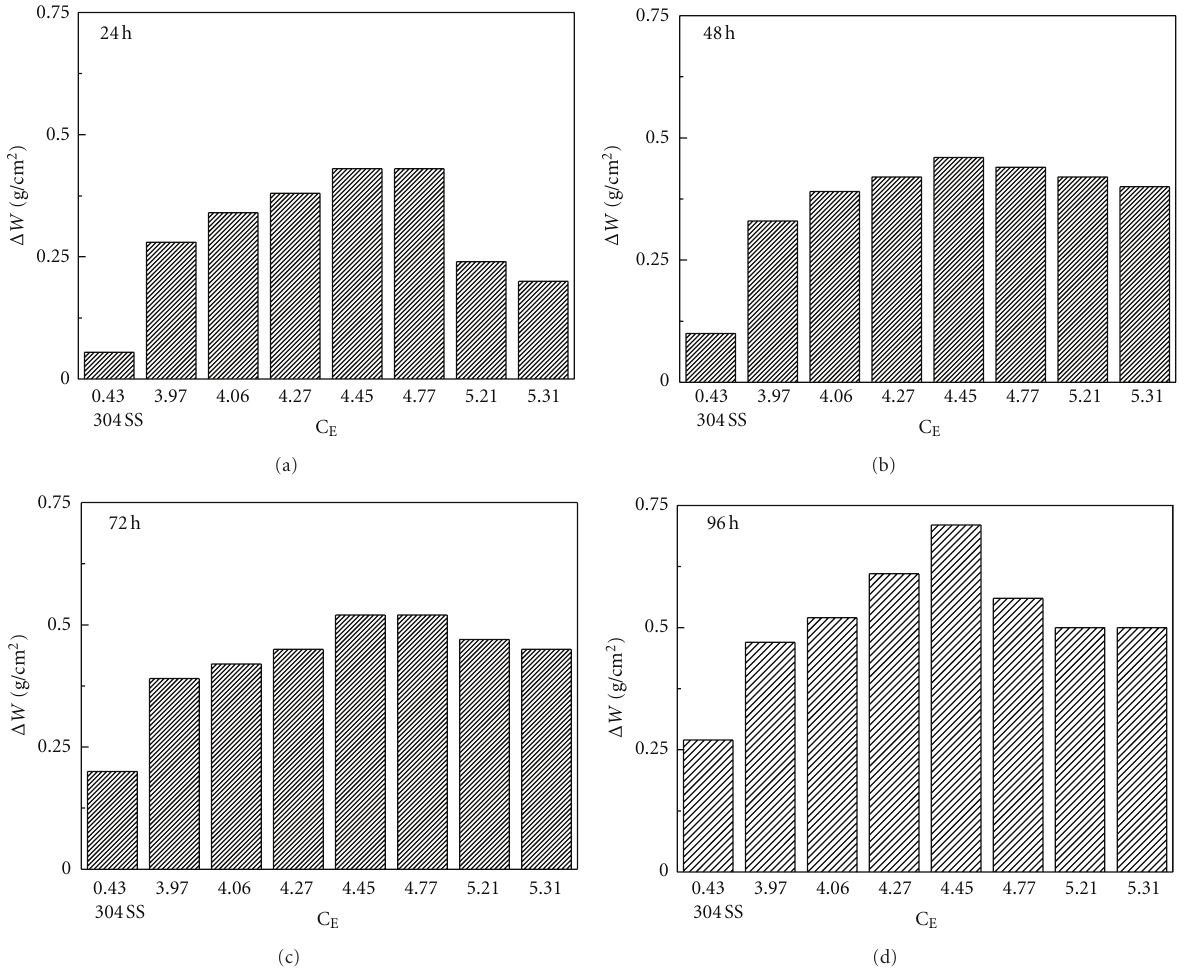
Figure 3: E ff ect of the equivalent carbon contents, C E , in the weight loss for the di ff erent high-chromium, high-carbon cast irons in NaCl- KCl at 670 ◦ C after di ff erent exposure